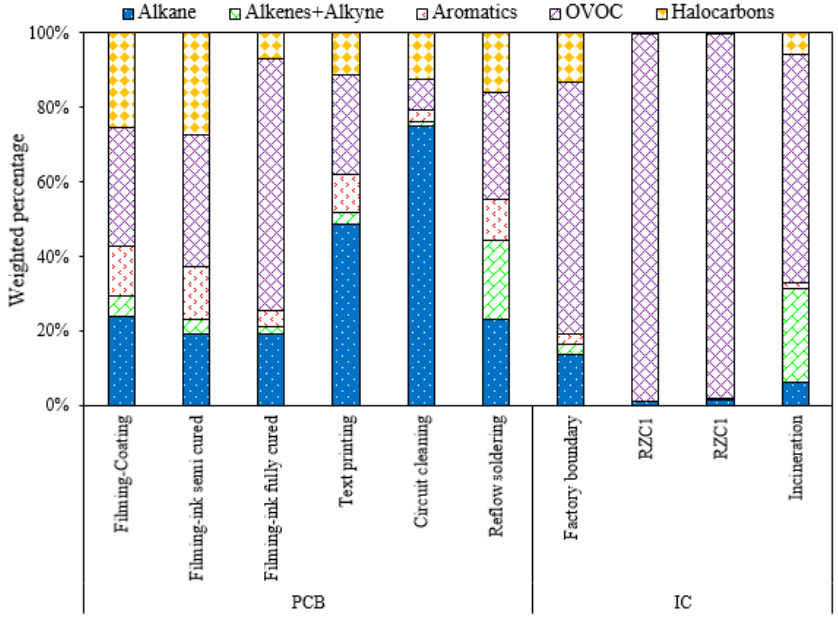
Figure 10. Overall VOC chemical group patterns of PCB and IC manufacturing (Note: RZC: exhaust was treated by rotary zeolite concentrator). Table 3. The top three VOC species and their percentage in total VOC mass concentration measured in each unit.